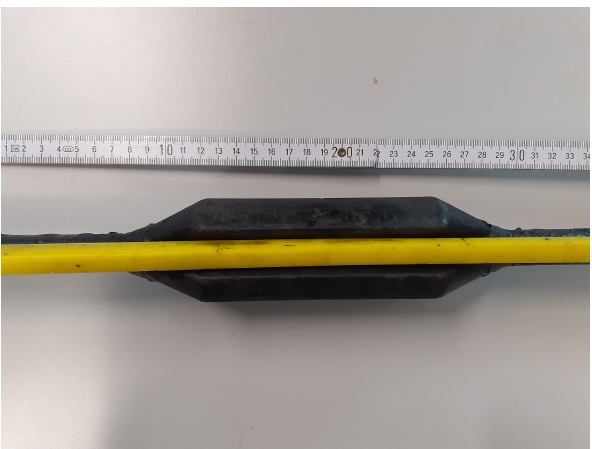
Figure 1. Downhole cable configuration of the sucker rod with a centralizer (black) and the fiber-optic cable